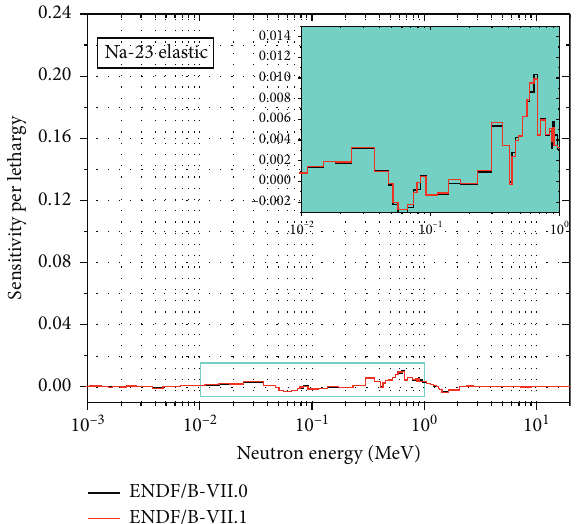
Figure 12: Energy-dependent sensitivities of k scattering cross section.